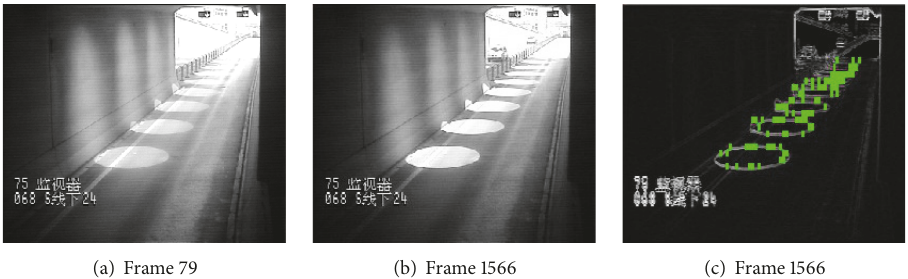
Figure 13: Shanghai Fuxing Road Tunnel Entrance.